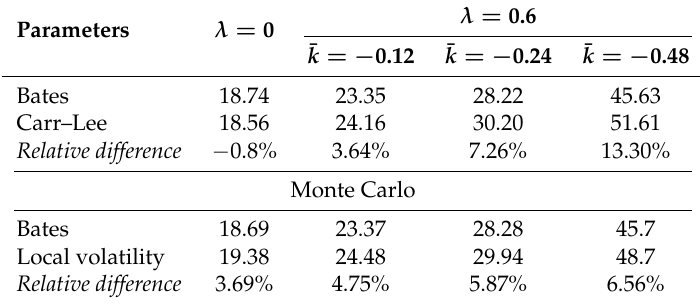
Table 9. Evolution of volatility swap prices under extreme Bates parameters, varying the jump parameters.